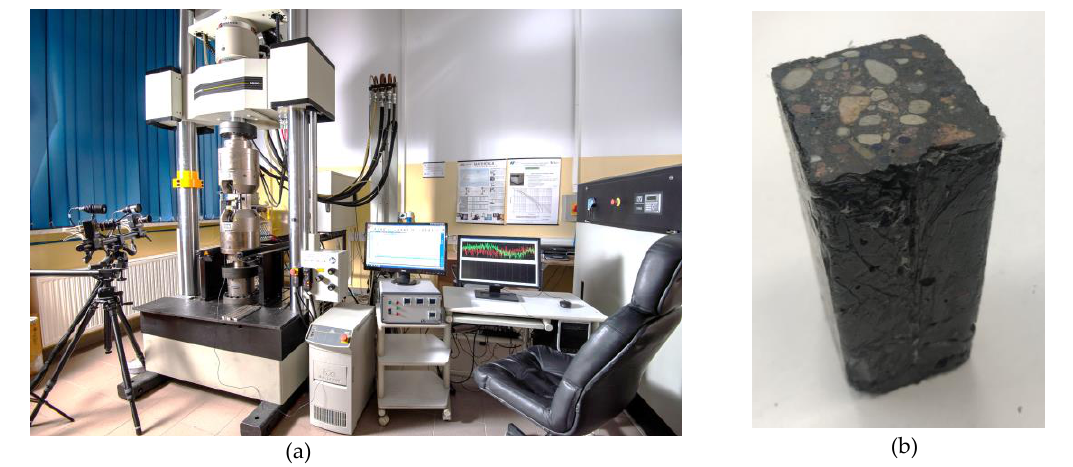
Figure 2. Test stand for compression tests ( a ) Instron 8850 press; ( b ) tested polymer concrete sample.